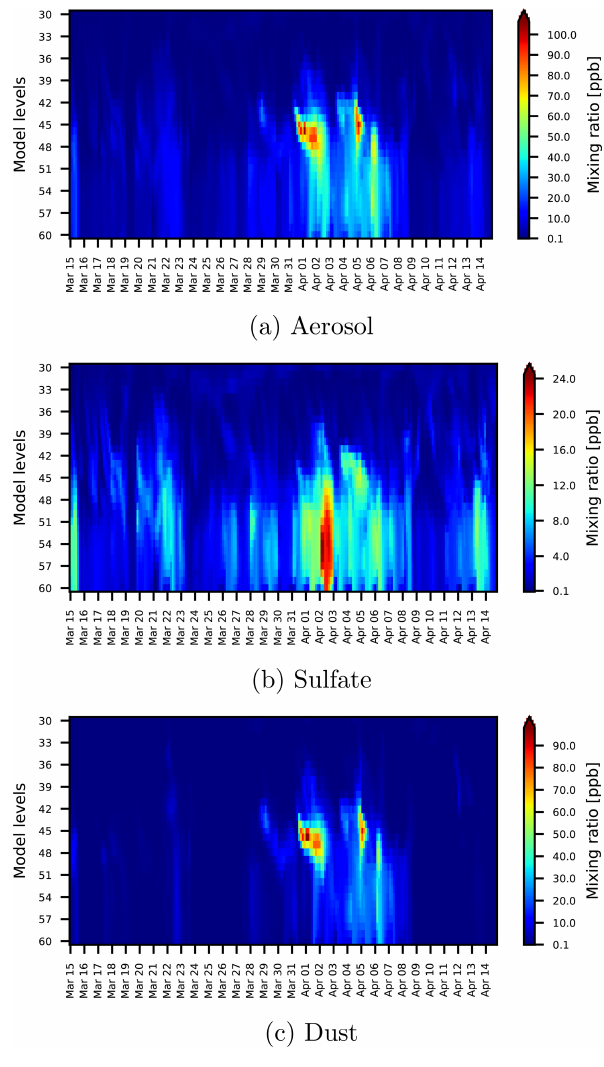
Figure 2. Time series of CAMS mixing ratios for total aerosol (a) , sulfate (b) , and dust (c) , Pillersdorf, 15 March–14 April 2014.